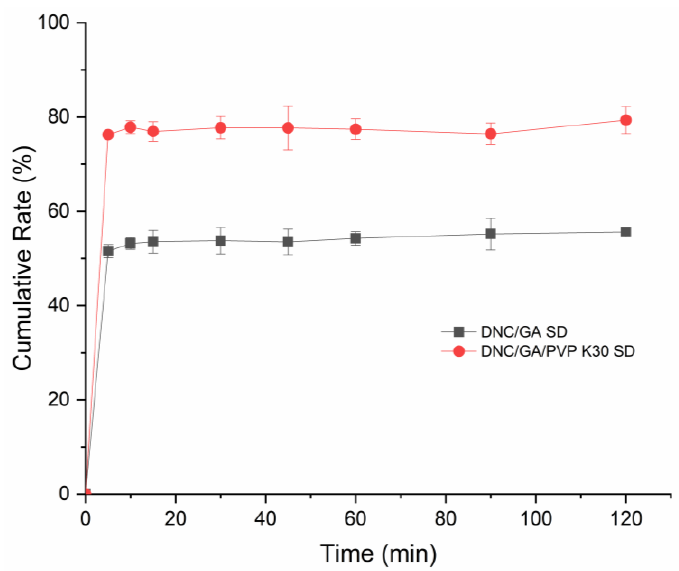
Figure 10. The cumulative release of DNC/GA SD and DNC/GA/PVP K30 SD.